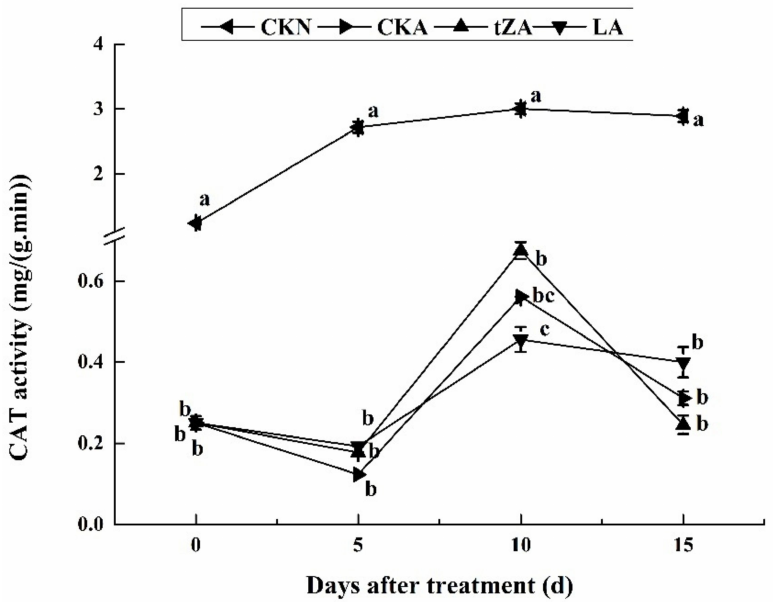
Figure 11. The changes of CAT activity in CKN, CKA, tZA and LA groups after the treatment. Different lower-case letters among different treatment groups indicate significant differences based on one-way analysis of variance in SPSS 21.0 followed by the Duncan’s test ( p < 0.05). With the development of the loquat seed, the expression of a CAT related gene (F01_i2_LQ_F01 | c39694/f1p0/2142) showed a similar trend of decreasing after rising